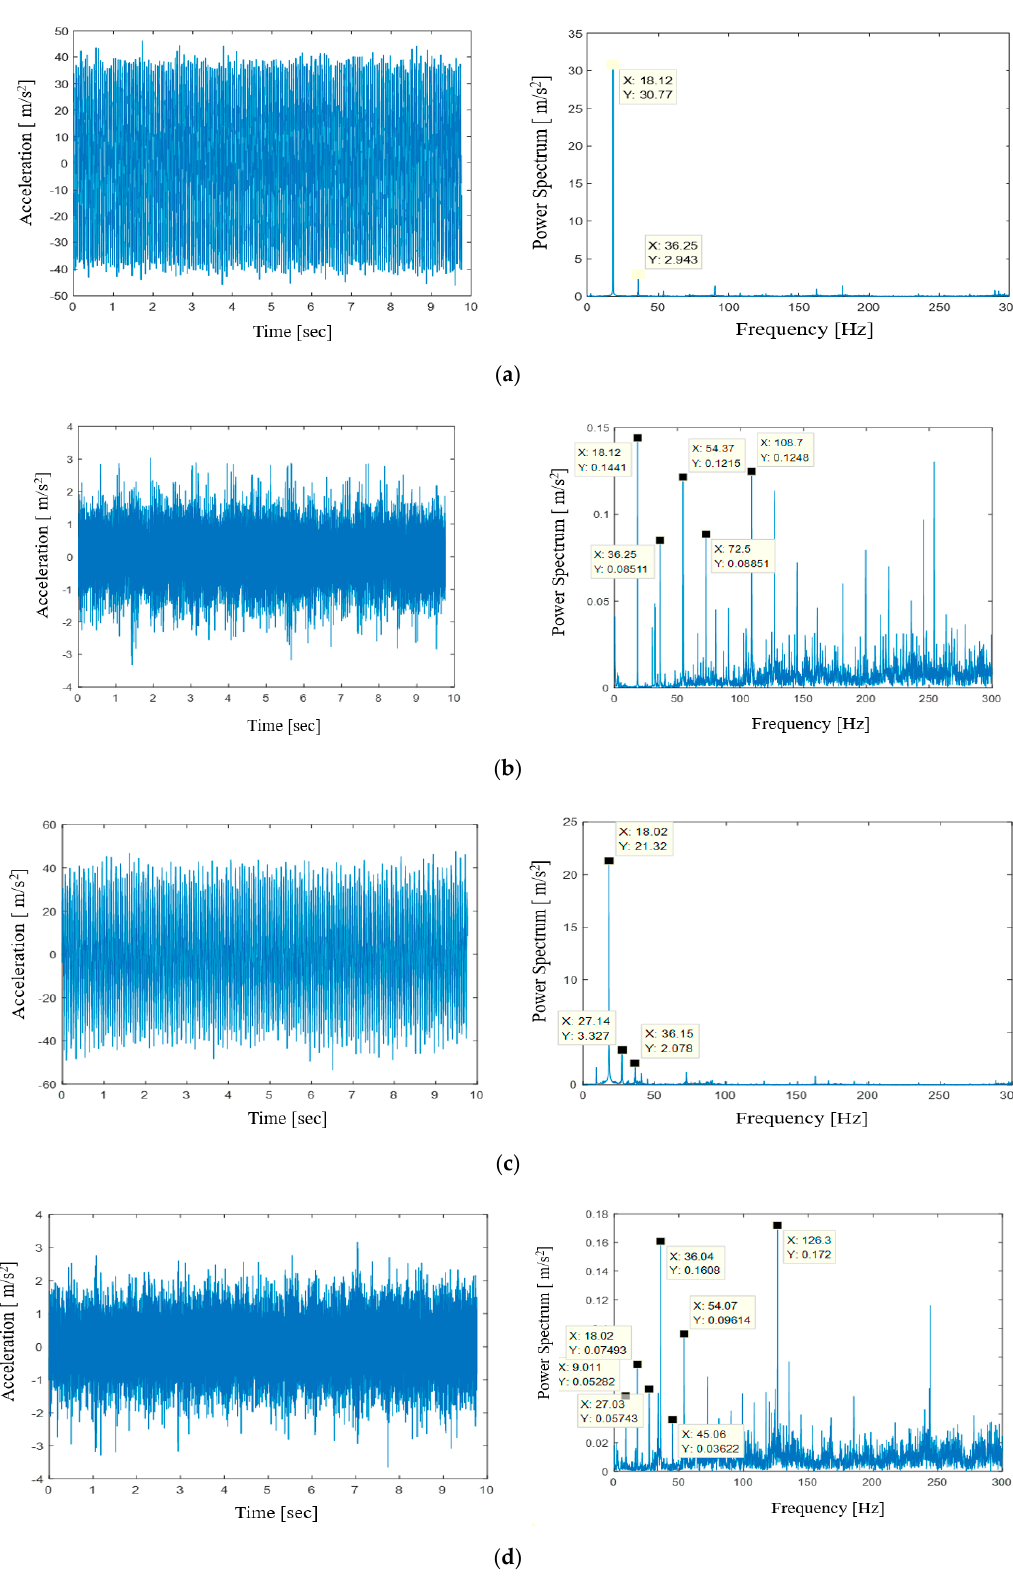
Figure 6. Vibration responses of the sand unit in time and frequency domains; ( a ) Vibration response at the top point of the coil spring: sand unit operating only; ( b ) Vibration response at the bottom point of the coil spring: sand unit operating only; ( c ) Vibration response at the top point of the coil spring: entire facilities operating condition; ( d ) Vibration response at the bottom point of the coil spring: entire facilities operating condition.